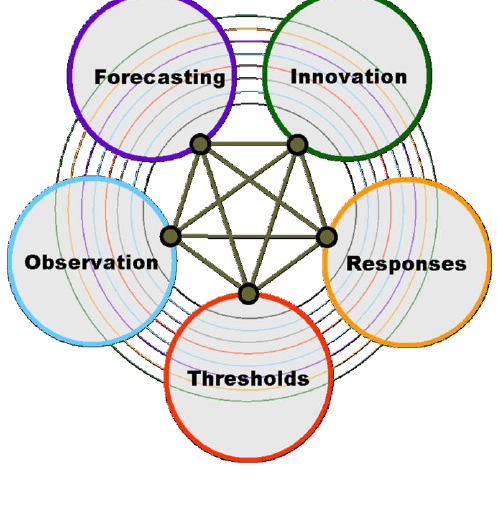
Figure 1. The five ICSU identified Grand Challenges in Global Sustainability Research as identified by